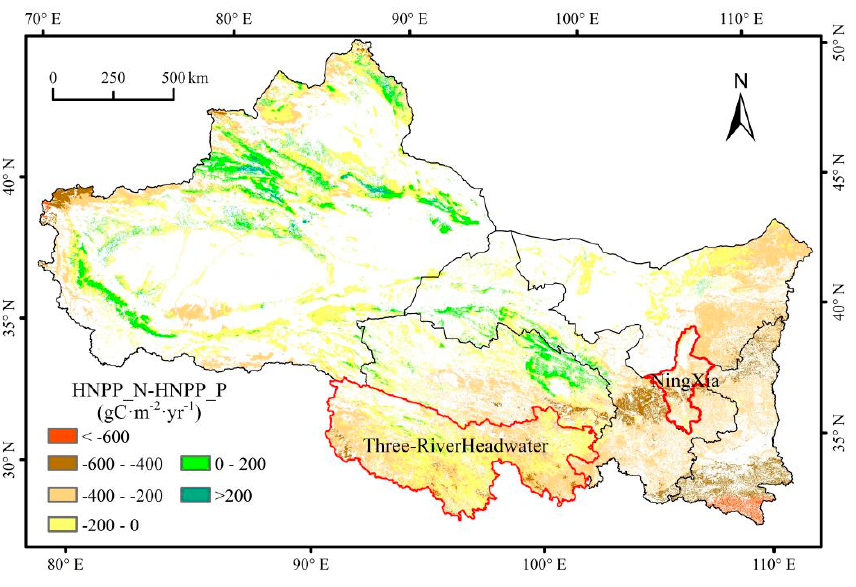
Figure 16. Difference between HNPP_N and HNPP_P from 2001 to 2017.